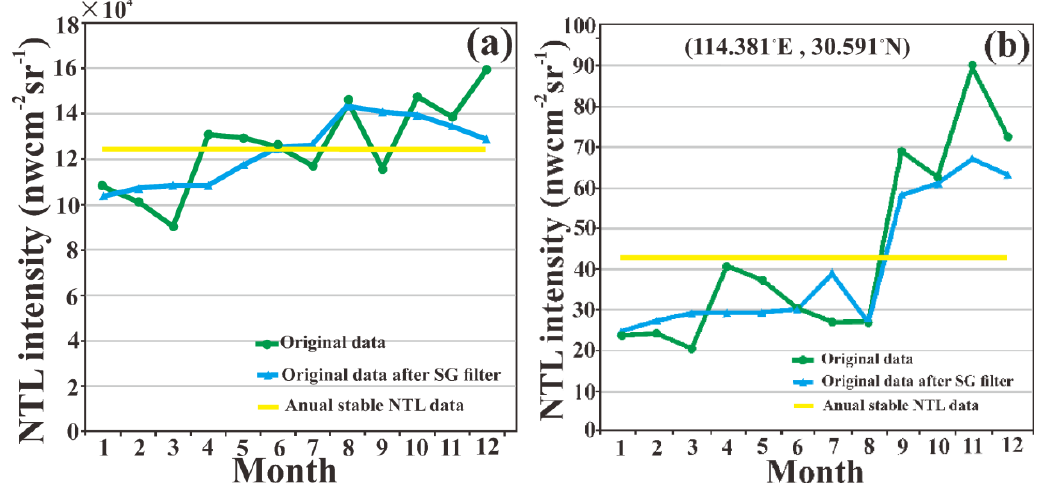
Figure 6. Temporal variations of Wuhan city in 2013: ( a ) temporal variation of NTL intensity at the city scale; ( b ) temporal variation of NTL intensity at the pixel scale.